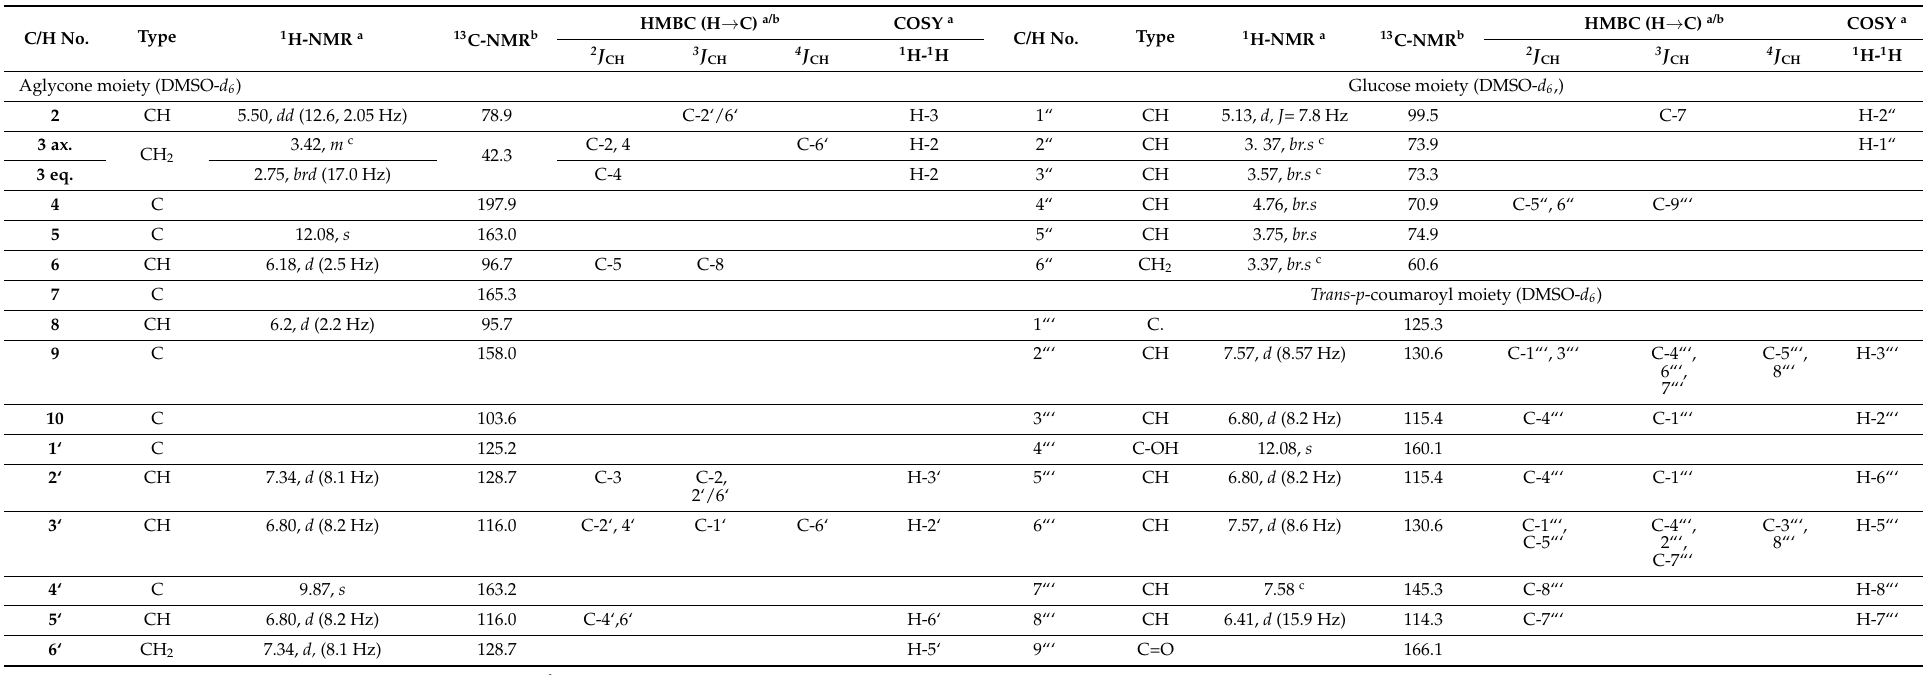
Table 3. NMR spectral data of compound E7 in DMSO- d 6